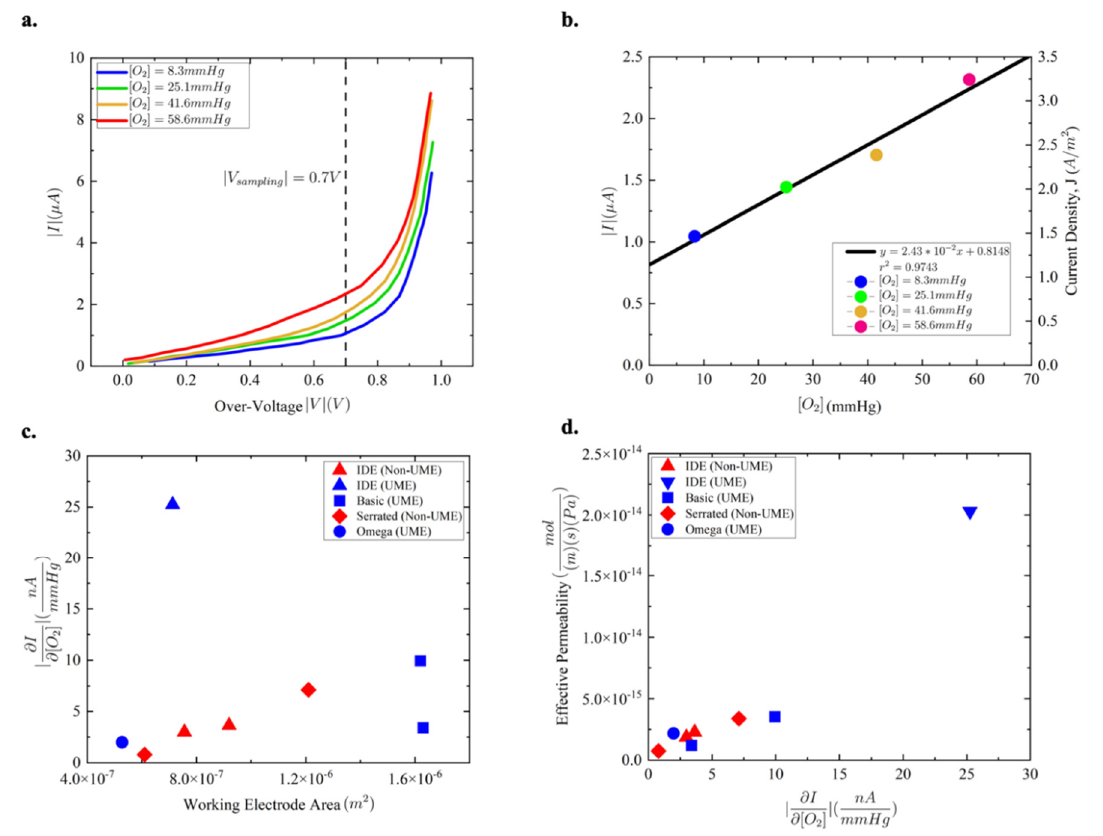
Figure 4. ( a ) I–V trace for the IDE_sep10 µm_width20 µm device, featuring multiple response sig- nals across an over-voltage sweep from 0 V to − 1 V at 4 chosen dissolved oxygen concentrations: 8.3 mmHg, 25.1 mmHg, 41.6 mmHg, and 58.6 mmHg. ( b ) Signal currents (µA) and current densities (A/m 2 ) for the IDE_Sep10 µm_width20 µm device at the 4 different dissolved oxygen concentrations under a − 0.7 V over-voltage device bias. ( c ) The device current response (nA/mmHg) according to a 50.3 mmHg change in oxygen concentration plotted against the working electrode area. A clear cor- relation with the working electrode area is present for the devices possessing standard microelec- trode dimensions (red icons), whereas ultramicroelectrode devices (blue icons) appear to lose the correlation. ( d ) Device signal responses (nA/mmHg) plotted against the calculated permeabilities of the PDMS/Nafion membrane, displaying a clear positive correlation between signal response and